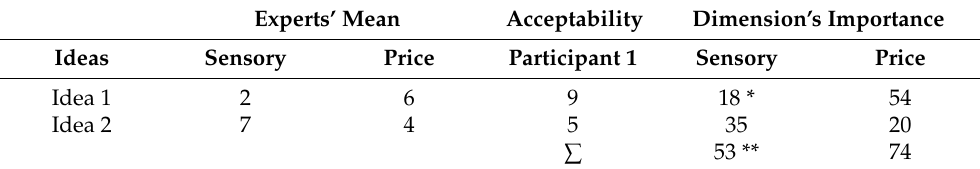
Table 1. Fictitious example of the calculation of the dimensions’ importance for participant 1.